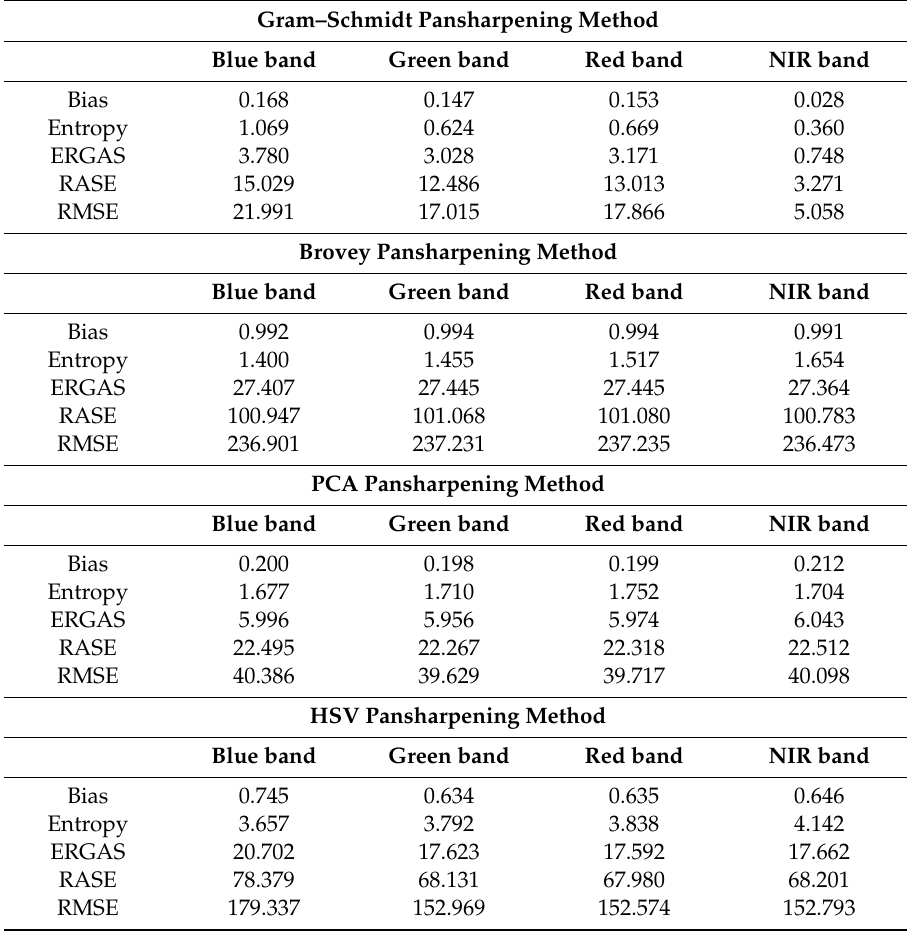
Table 1. Overall statistics for each fused method and each spectral band used for integrating Landsat 8 and Sentinel 2 images. The five di ff erent quality methods implemented in this study are also provided. Lowest values (closest to zero) are underlined and indicated in